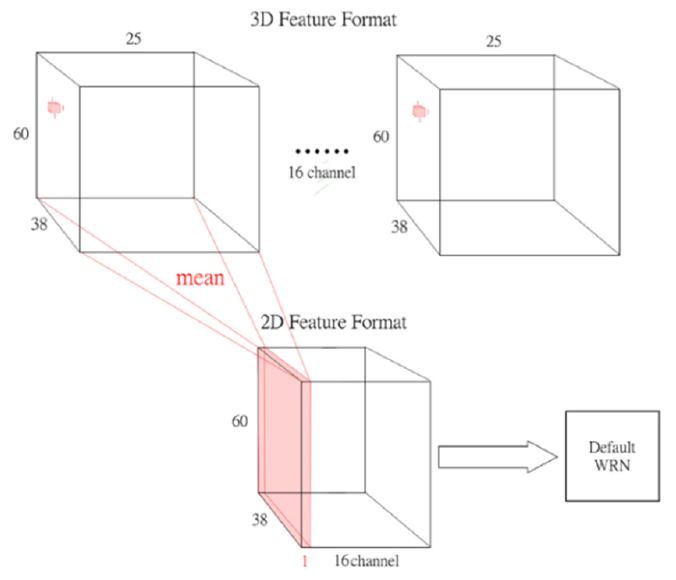
Figure 8. 3D features compressed along the temporal axis.